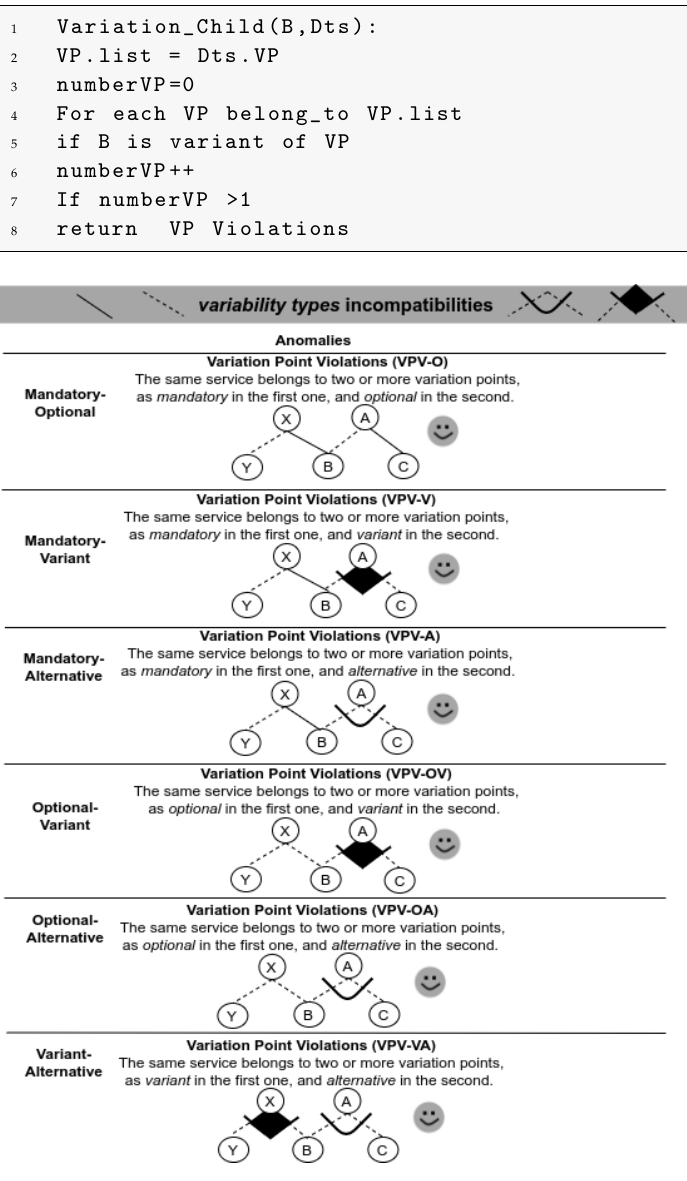
Figure 12. Validation scenarios involving variability types